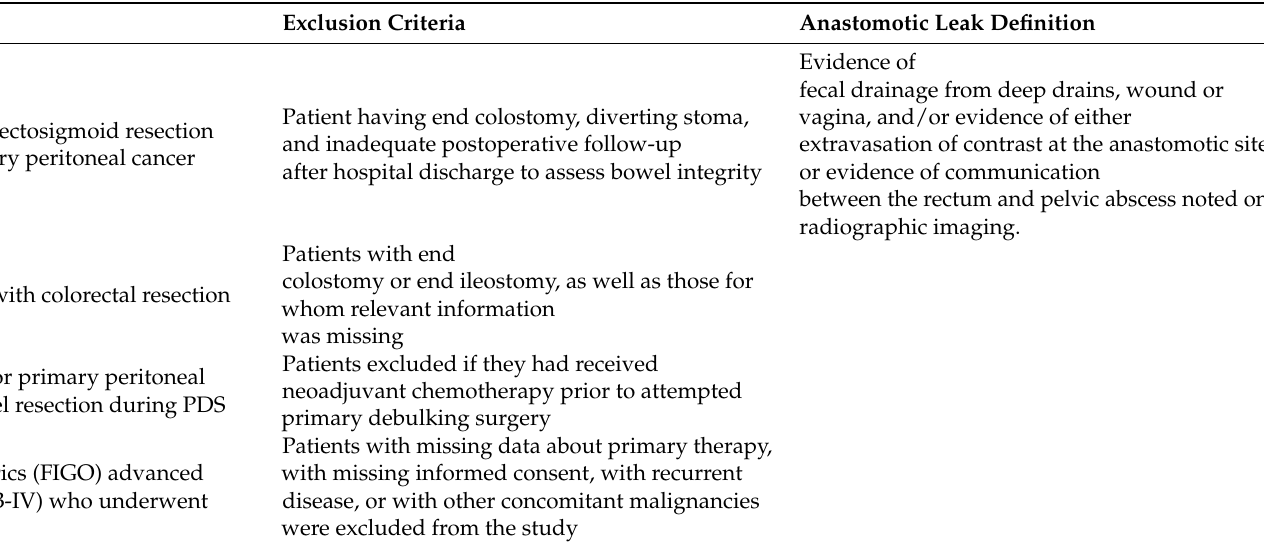
Table 2. Definition of anastomotic leak among the included studies as well as inclusion/exclusion